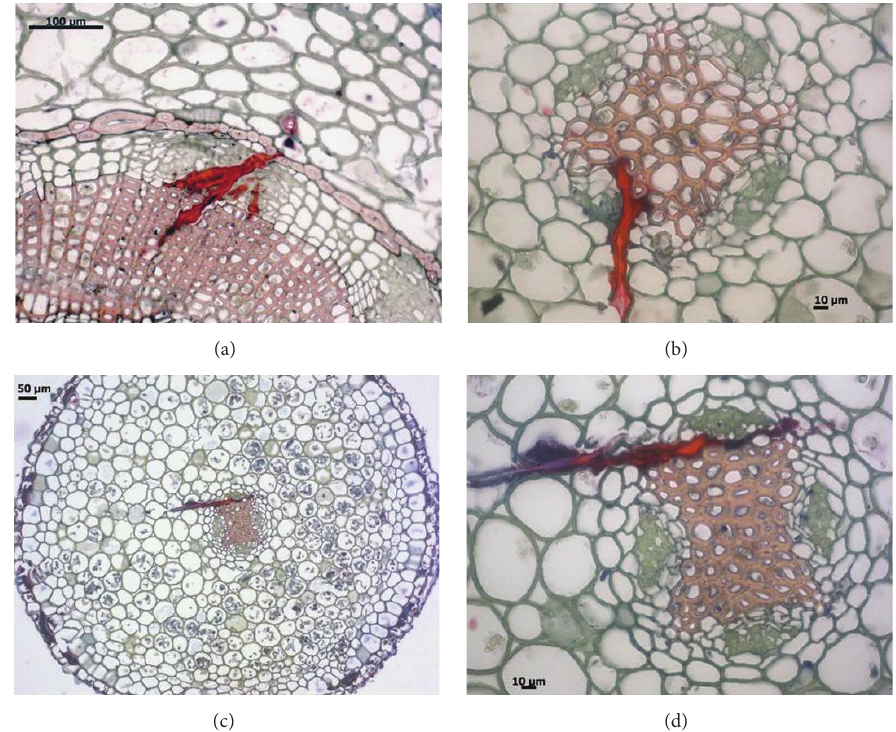
Figure 3: Histological sections of Griselinia racemosa roots with salivary sheaths of Mapuchea chilensis . (a) Branched sheath, with one branch penetrating into the xylem. (b) Sheath terminating in the outermost layer of the xylem. ((c) and (d)) Sheath terminating equivocally, between the phloem and the xylem.